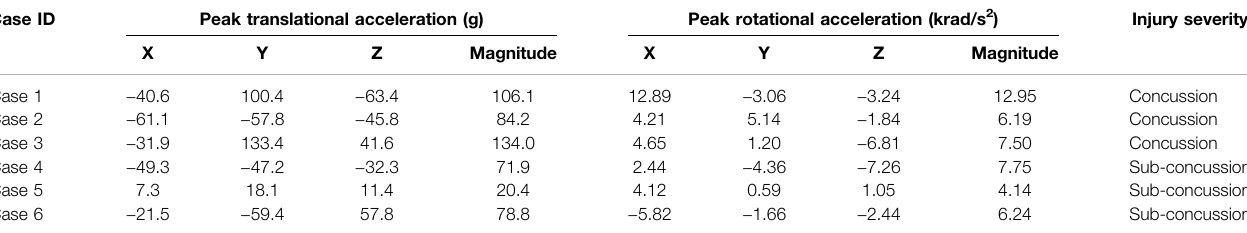
TABLE 2 | Peaks of translational acceleration and rotational acceleration and injury severity of the six cases considered in this study. The X, Y, and Z axes are the same as thoseintheskull- fi xedcoordinatesystemin Figure1A .NotethatCases1 – 2andCases4 – 5areon- fi eldimpactsmeasuredbythemouthguard(Hernandezetal.,2015), while Case 3 and Case 6 are laboratory-reconstructed impacts (Pellman et al., 2003; Sanchez et al.,